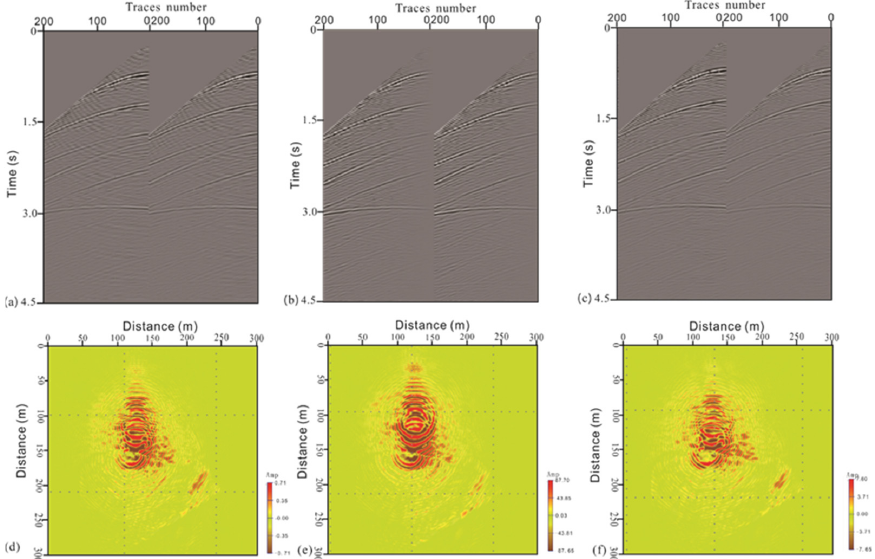
Figure 12. Part of single-shot records, modulated results, and imaged depth slices in the calculation of 3D SOGs: ( a ) part of the original single-shot records; ( b ) part of the single-shot records modulated with transverse offset; ( c ) part of the single-shot records modulated with horizontal offset; ( d ) depth slice of the results from the migration of original single shots; ( e ) depth slice of the results from the migration of Figure 12b; ( f ) depth slice of the results from the migration of Figure 12c.